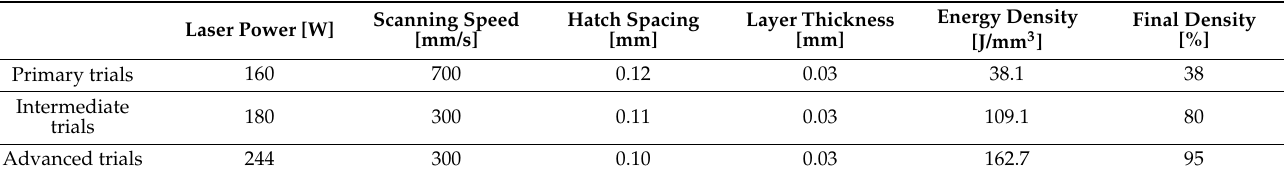
Table 3. Printing parameters of LPBF